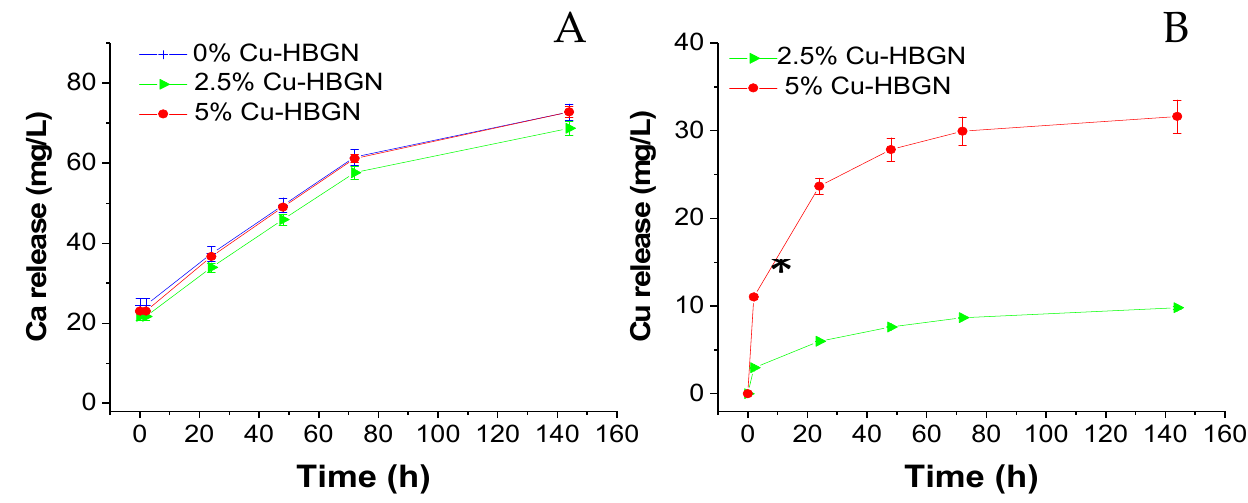
Figure 3. Cumulative release of calcium ( A ) and copper ( B ) from HBGN up to 6 d soaked in α -MEM. Data standardized to a release of 1 mg/mL of HBGN. * Significant differences between 2.5 and 5% Cu-HBGN ( p < 0.05).